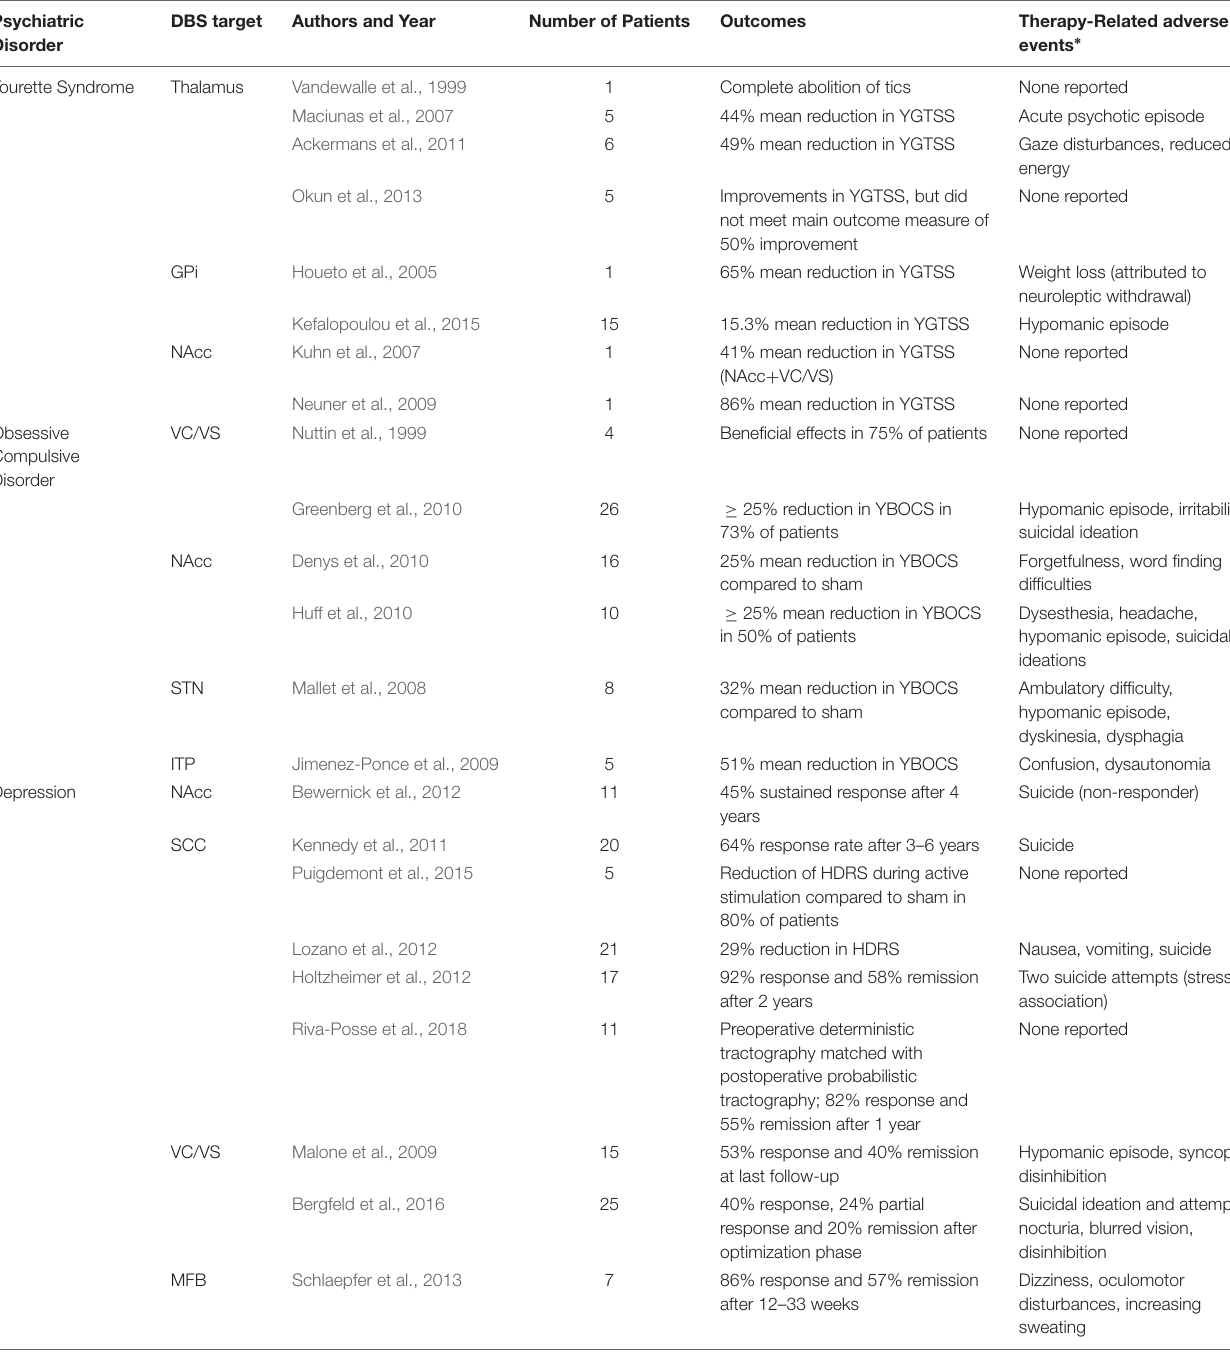
TABLE 2 | Deep brain stimulation for psychiatric disorders: selected